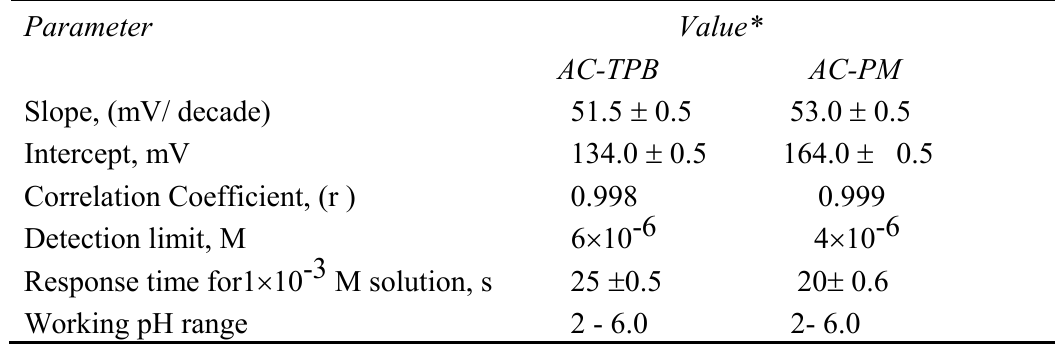
Table. 1 . Response characteristics of the PVC membrane